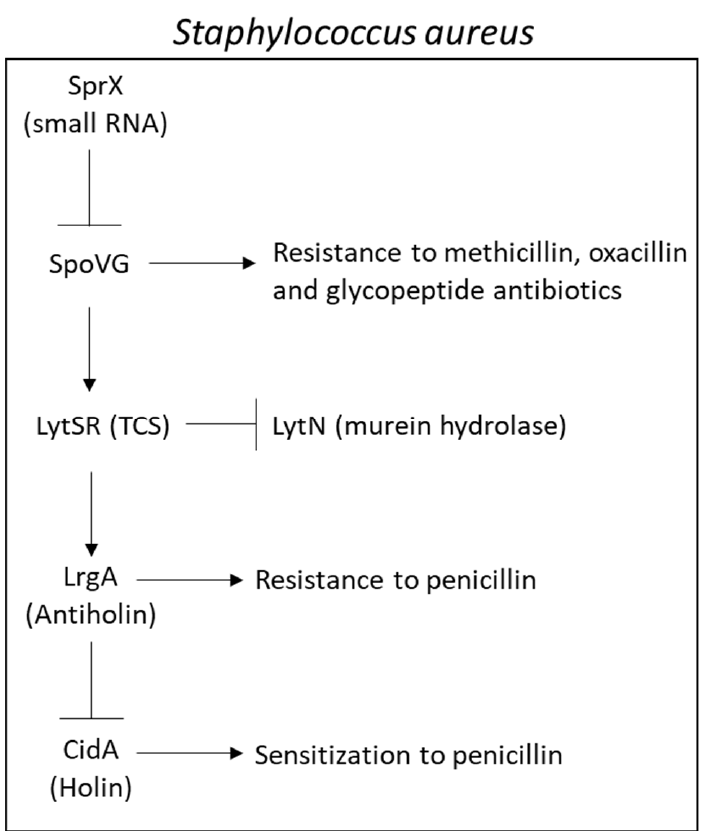
Figure 7. Regulation of the antiholin LrgA–holin CidA system by the small SprX RNA. SprX inhibits the expression of the RNA-binding protein SpoVG, which positively regulates the TCS LytSR. LytSR positively regulates the antiholin LrgA which antagonizes the activity of the holin CidA. SpoVG induces methicillin and oxacillin resistance by promoting cell wall synthesis and inhibiting cell wall degradation. LrgA and CidA affect the response to penicillin by respectively inhibiting or activating murein hydrolase activities. Altogether, the overexpression of SprX results in increased susceptibility to β